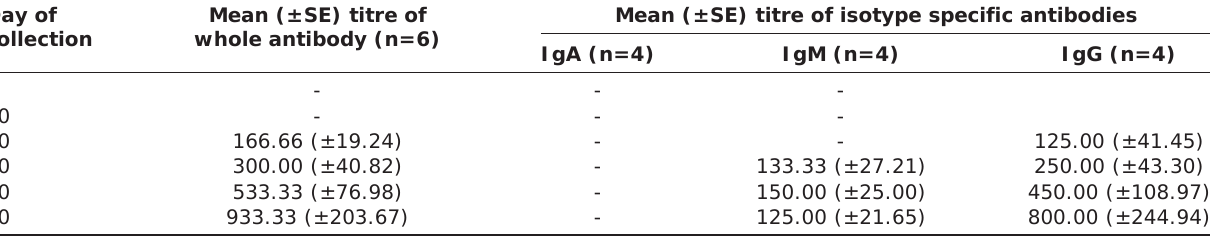
Table-2: Whole antibody tittres and isotype-specific antibody tittres against K88ac ETEC in egg yolk of immunized hens as determined by indirect ELISA. Day of